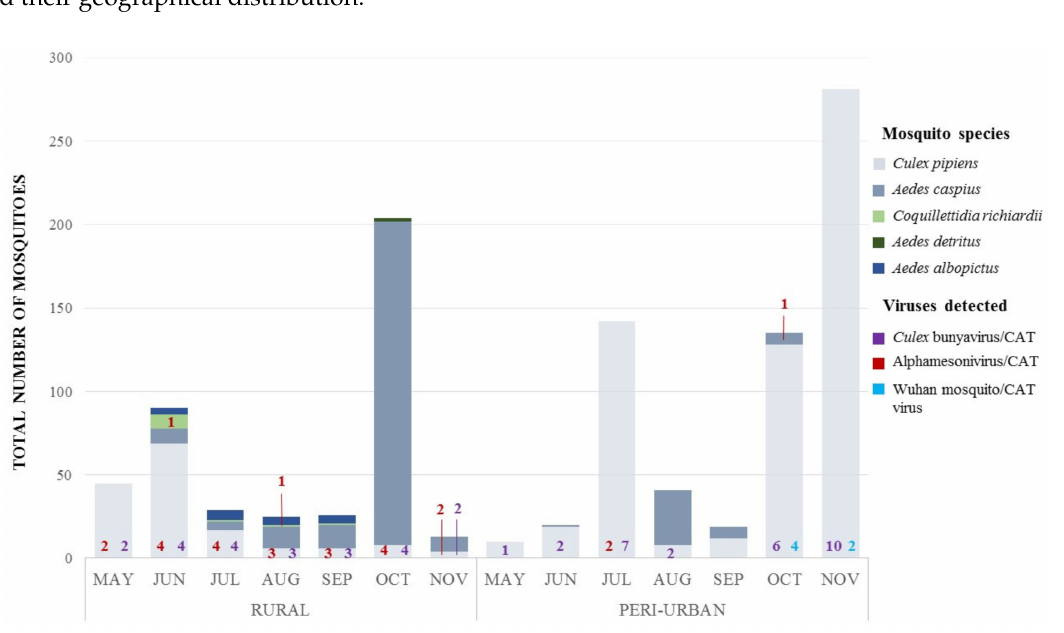
Figure 2. Mosquito species dynamics and virus occurrence in rural and peri-urban biotopes from the Llobregat River Delta. Cumulative bars represent the total number of female mosquitoes captured per month per sampling site. Numbers in color correspond to the total number of mosquito pools that tested positive for a given virus on a particular month and sampling